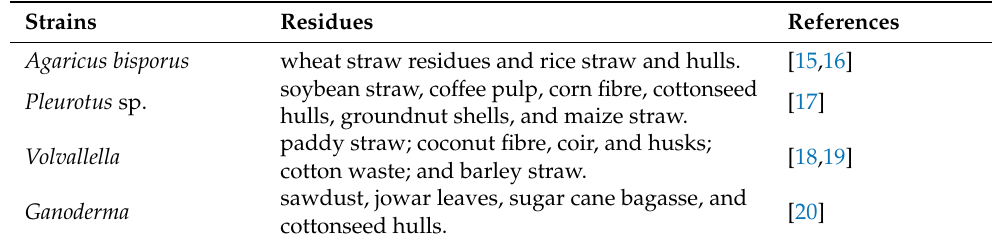
Table 1. Various crop residues used in mushroom